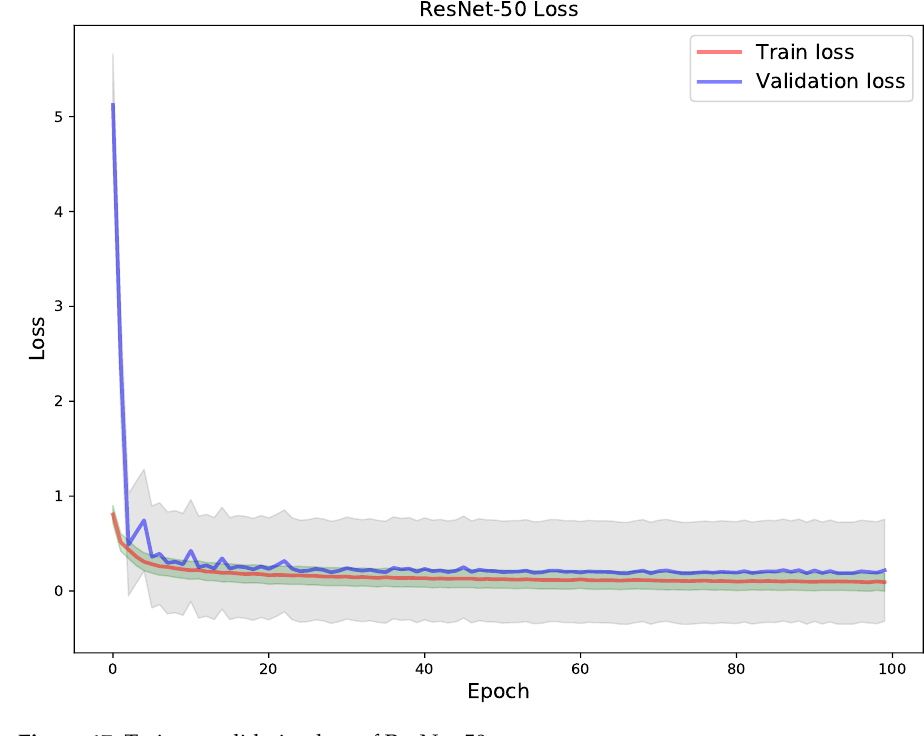
Figure 17. Train vs validation loss of ResNet-50.